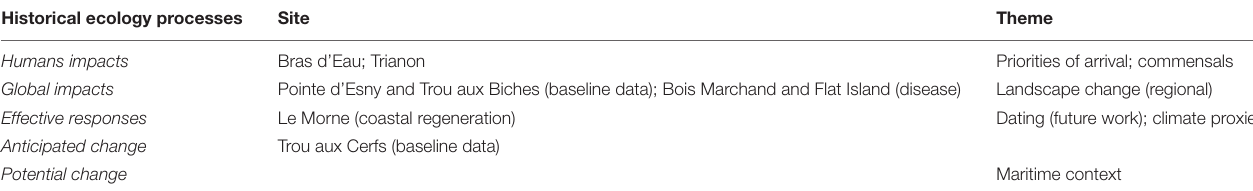
TABLE 1 | Sites and themes nested within Crumley’s five historical ecology processes. Historical ecology